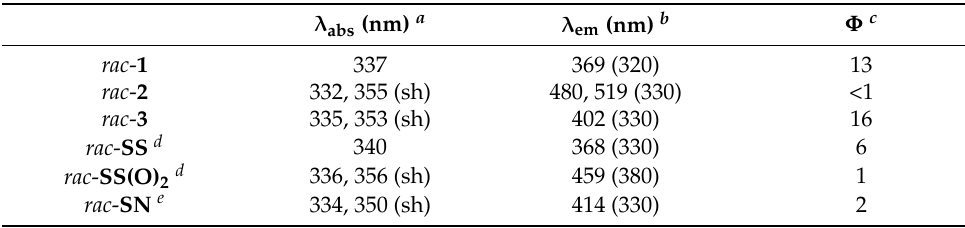
Figure 3. ( a ) UV–vis absorption and ( b ) PL spectra of rac - 1–3 in CH 2 Cl 2 . Table 1. Photophysical properties of spiro-fused PACs 1 – 3 .